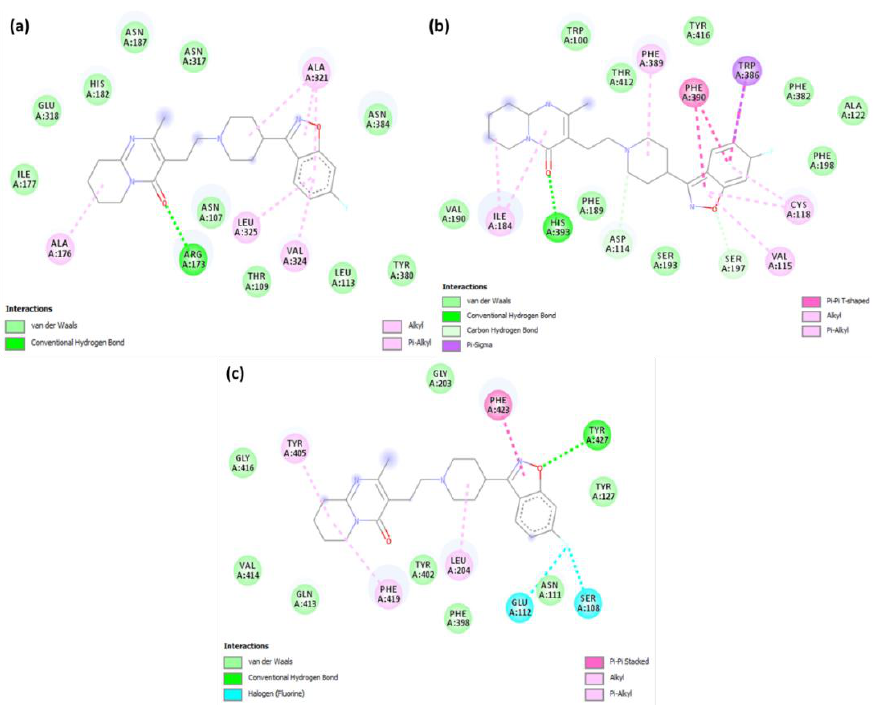
Figure 6. 2D representations of interactions between risperidone and ( a ) serotonin, ( b ) dopamine, and ( c ) adrenergic receptors.